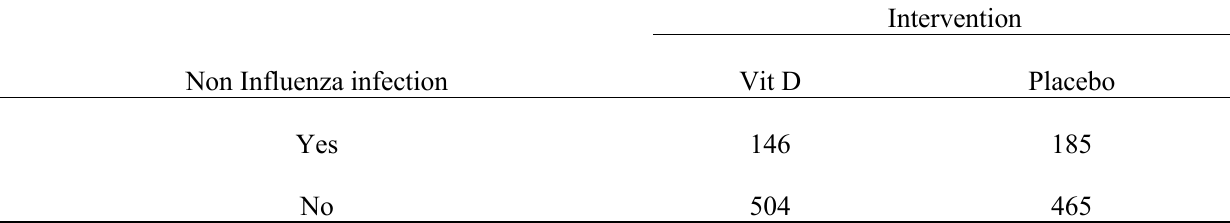
Table 5. Comparison of Vitamin D and Placebo on Influenza